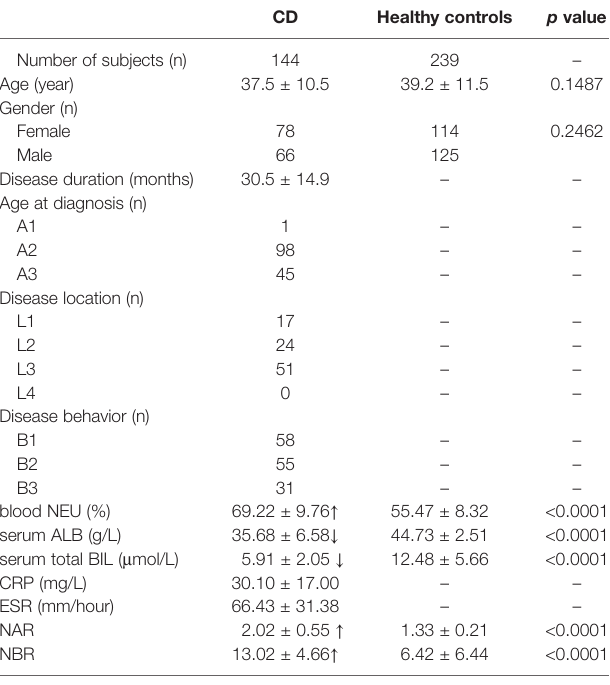
TABLE 1 | Demographics and clinical parameters of CD patients and healthy